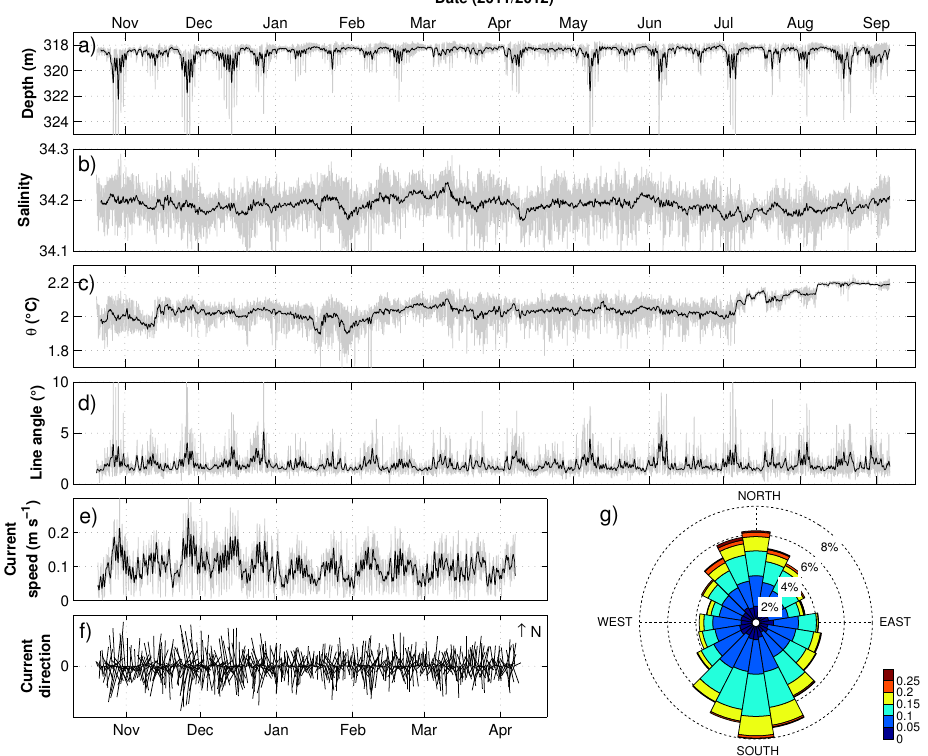
Figure 3. Hydrological properties recorded by the instrument mooring at station A3. (a) Depth of the CTD sensor, (b) salinity, (c) potential temperature, (d) line angle, and (e) current speed. In (a) – (e) , grey lines are raw data, and black lines are low-pass-filtered data with a Gaussian filter (40h window as suggested by the spectral analysis). (f) Direction and speed of currents represented by vectors (undersampled with a 5h interval) and (g) wind rose plot of current direction and intensities (dotted circles are directions relatives frequencies and colours refer to current speed (ms − 1 ) ).